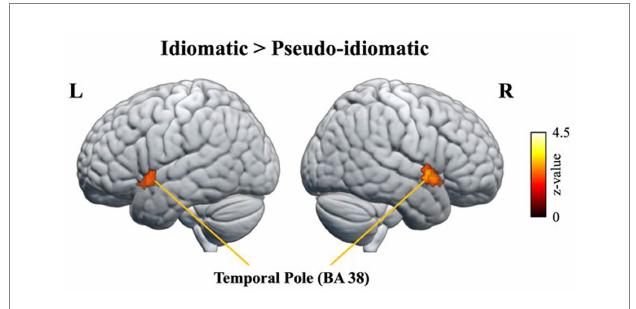
FIGURE 6 Contrast of idiomatic vs. pseudo-idiomatic